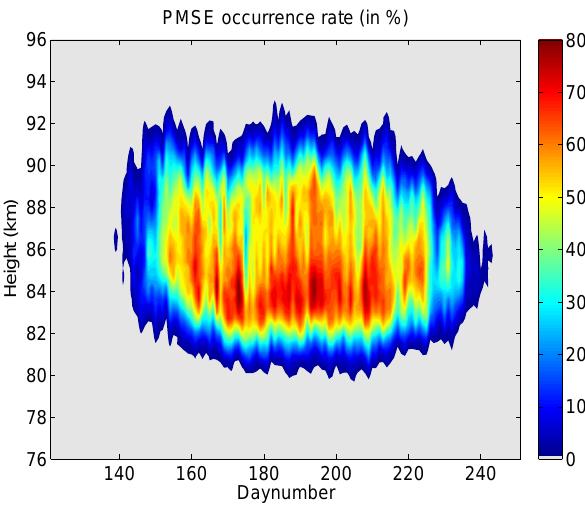
Fig. 2. Mean daily PMSE occurrence (averaged over 5 years) over Svalbard as a function of season and height. PMSE are present quasi exclusively between 80 and 92km from mid May to end of August (daynumbers about 140–245).